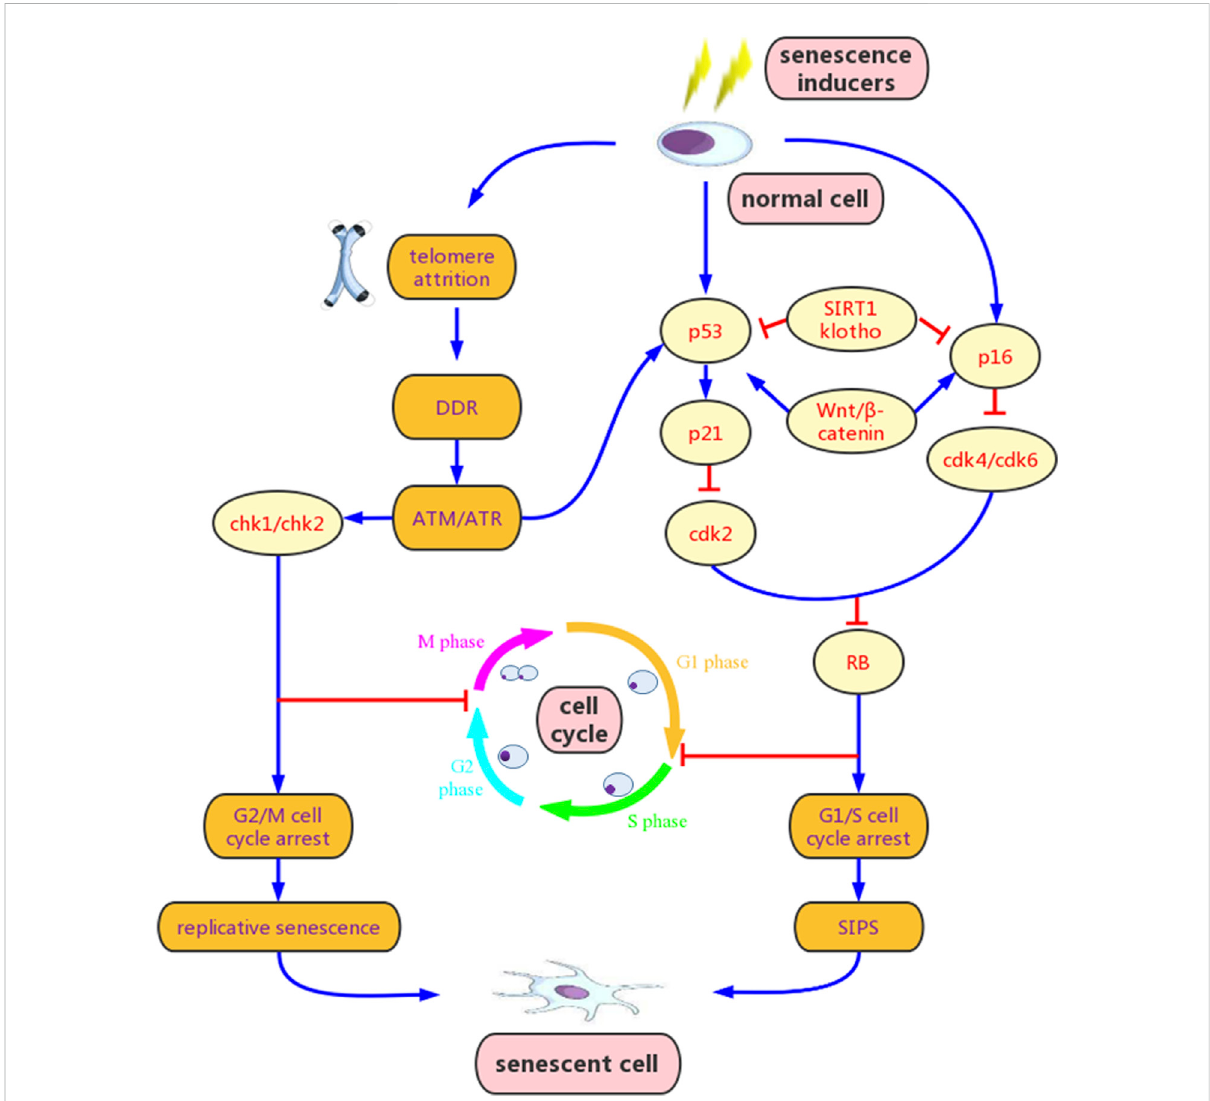
FIGURE 1 Mechanisms of cellular senescence. Senescence inducers, such as oxidative stress, DNA damage, mitochondrial dysfunction and epigenetic stress, can activate the ataxia telangiectasia mutated/ataxia telangiectasia and Rad3-related (ATM/ATR) signaling and other multiple pathways, resulting in p53 phosphorylation and increased p21 transcription, and/or p16 over-experession. Activation of p21 and p16 inhibits cyclin-dependent kinase 2 (CDK2) or CDK4/CDK6 and prevents retinoblastoma (RB) phosphorylation, leading to G1/S cell cycle arrest. Additionally, activated ATM/ATR signaling can also induce G2/M cell cycle arrest via checkpoint kinase 1 (Chk1) and Chk2. Wnt/ β -catenin promotes senescence by stimulating p53 and p16, while klotho and sirtuins 1 (SIRT1) inhibit senescence by blocking these pathways. Cellular senescence initially leads to elevated senescence-associated β -galactosidase (SA- β -gal) and senescence associated secretory phenotype (SASP) release. However, if senescence persisists, itmayevolvetochronic senescence andsecondarysenescence, and contributesto various degradations.DDR,DNAdamage response; SIPS, stress-induced premature